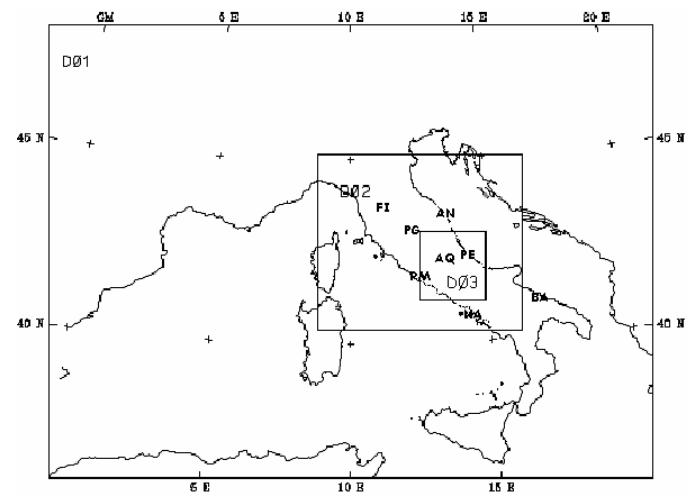
Fig. 4. Triple nested domain used for the simulations.